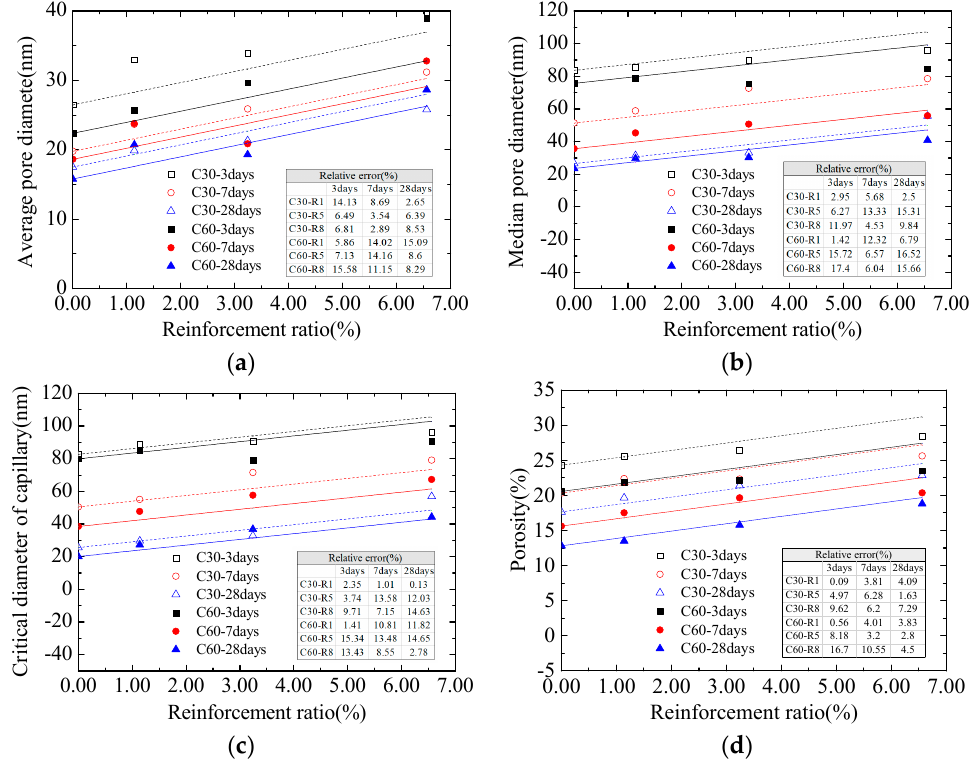
Figure 3. Connection between concrete pore structure and reinforcement ratio: ( a ) average pore diameter; ( b ) median pore diameter; ( c ) critical diameter of capillary; ( d ) porosity.